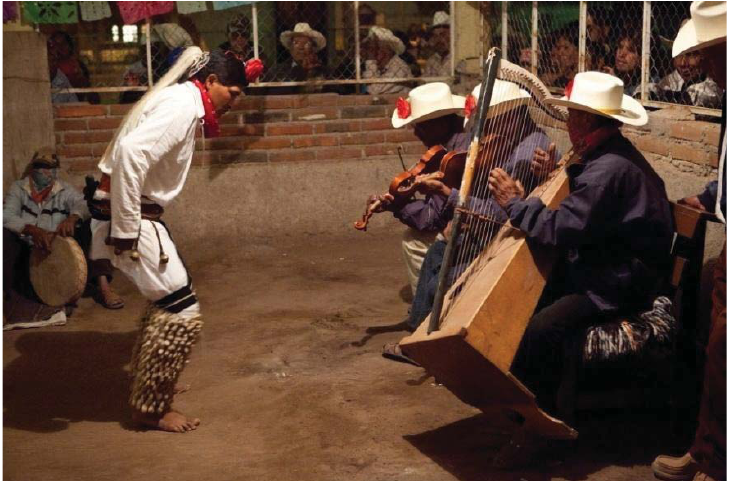
Figure 11. Mayo Pascola dancer, Masiaca, 2011. The dancer is wearing Rothschildia cocoons, known as ténaborim.